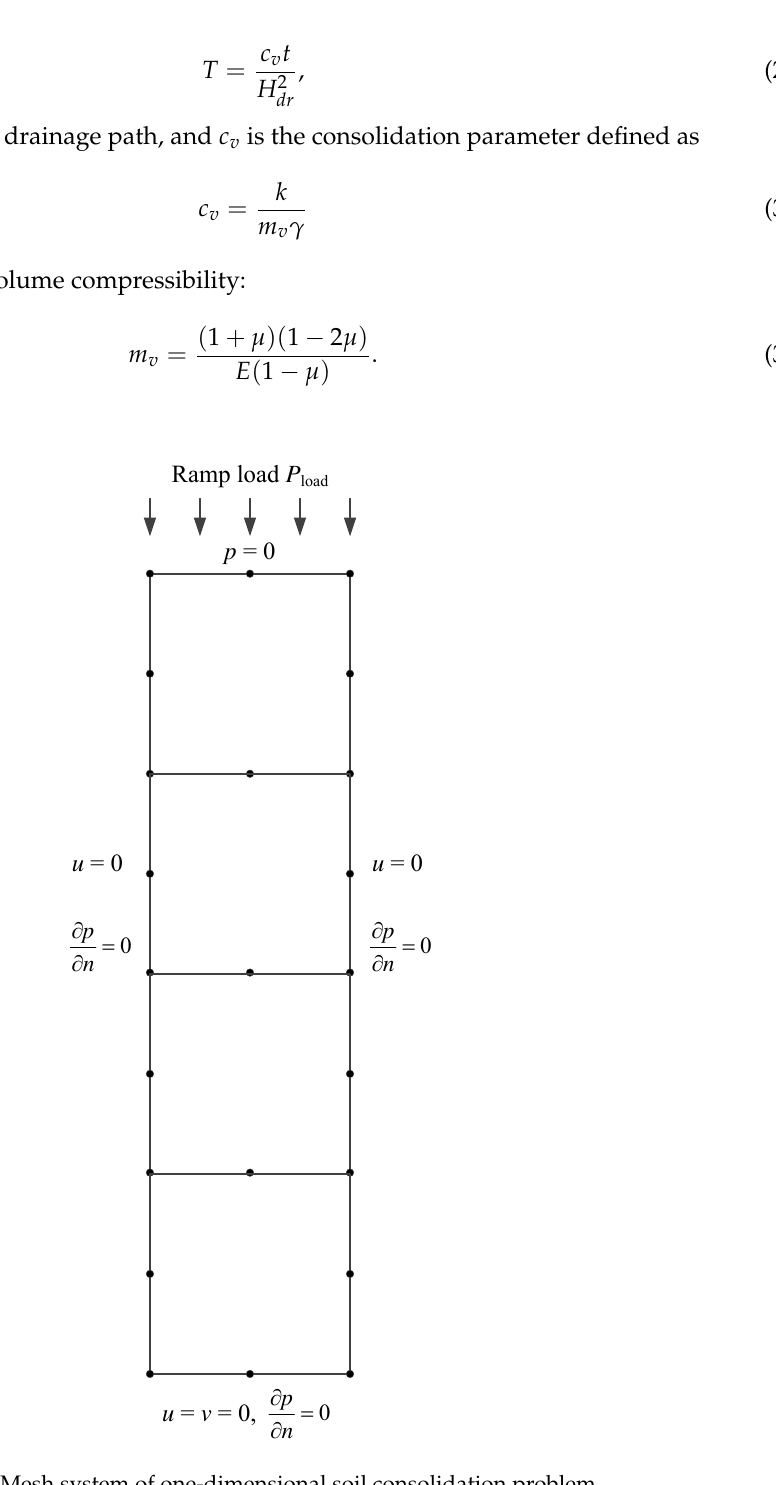
Figure 5. Mesh system of one-dimensional soil consolidation